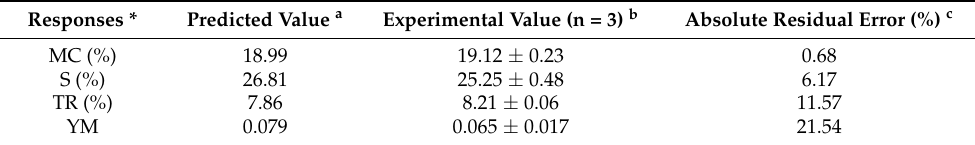
Table 4. Predicted and experimental responses of gelatin–whey protein–chitosan film prepared using the optimal FFS